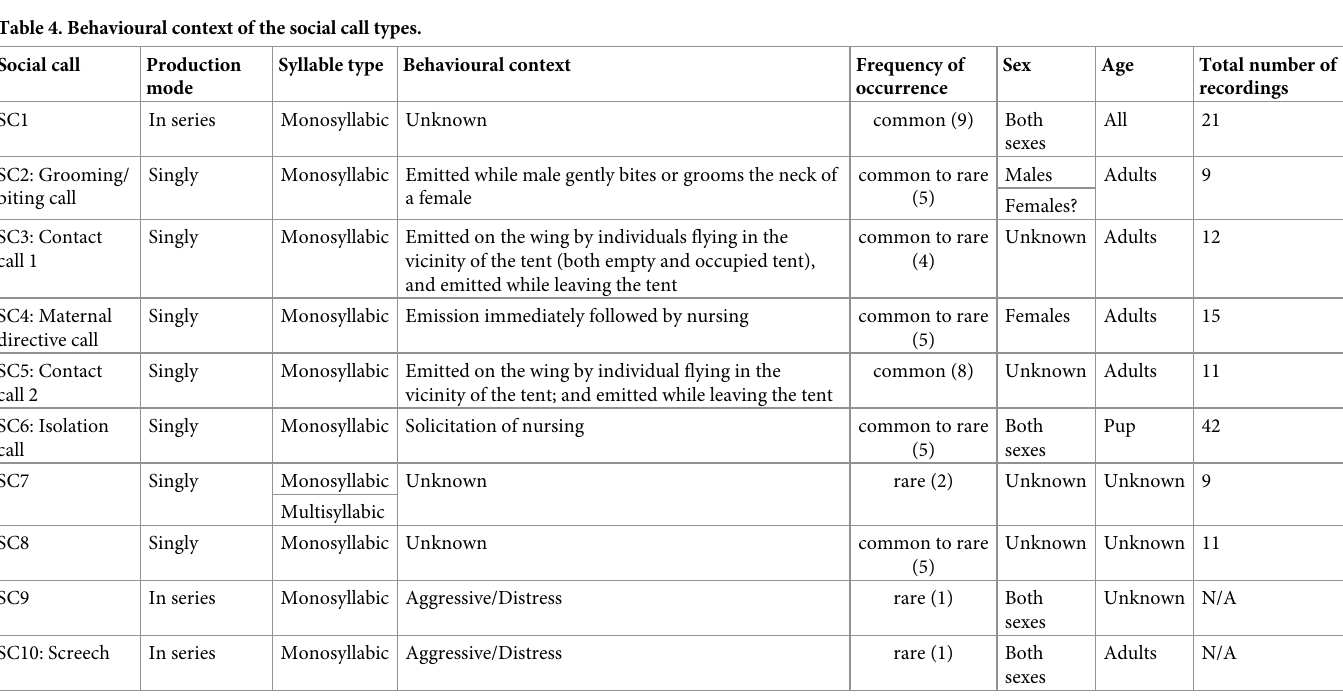
Table 4. Behavioural context of the social call